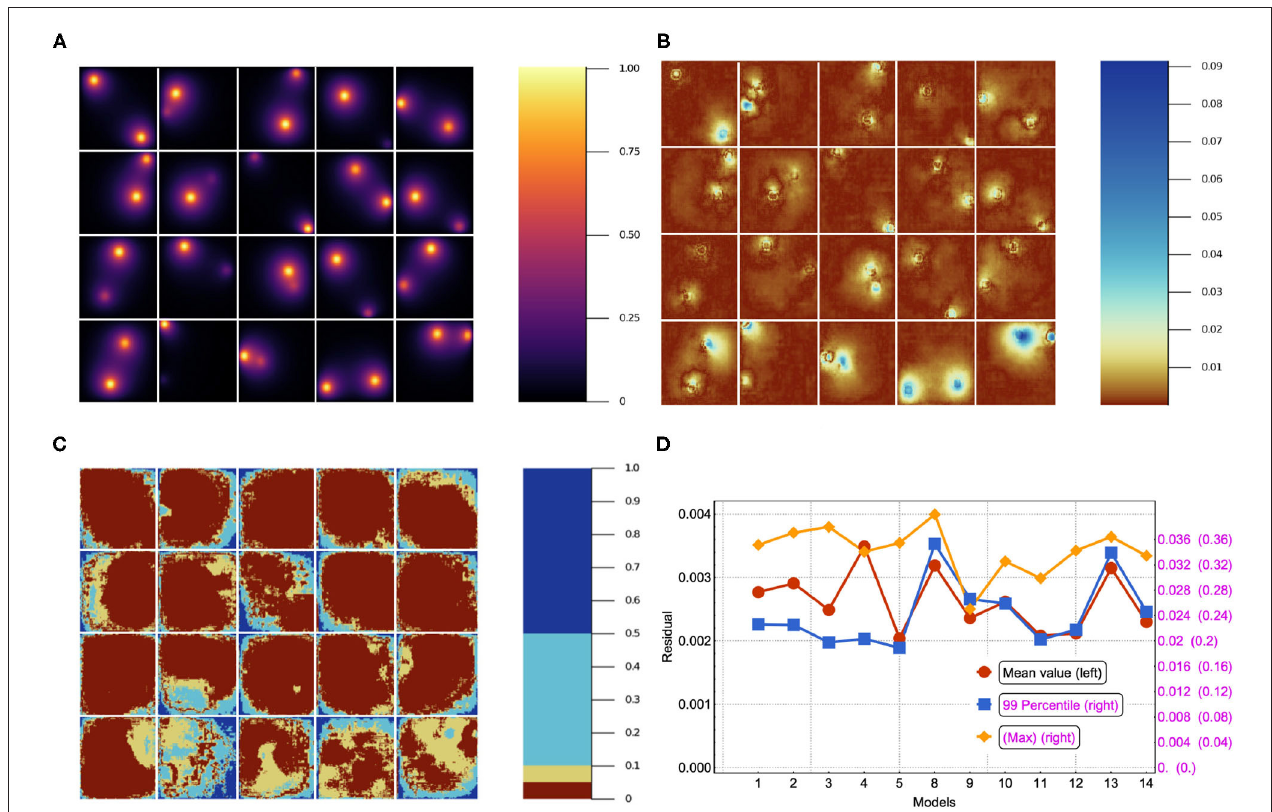
y β y β ) for 20 sample source images in the test set || i − |ˆ i|